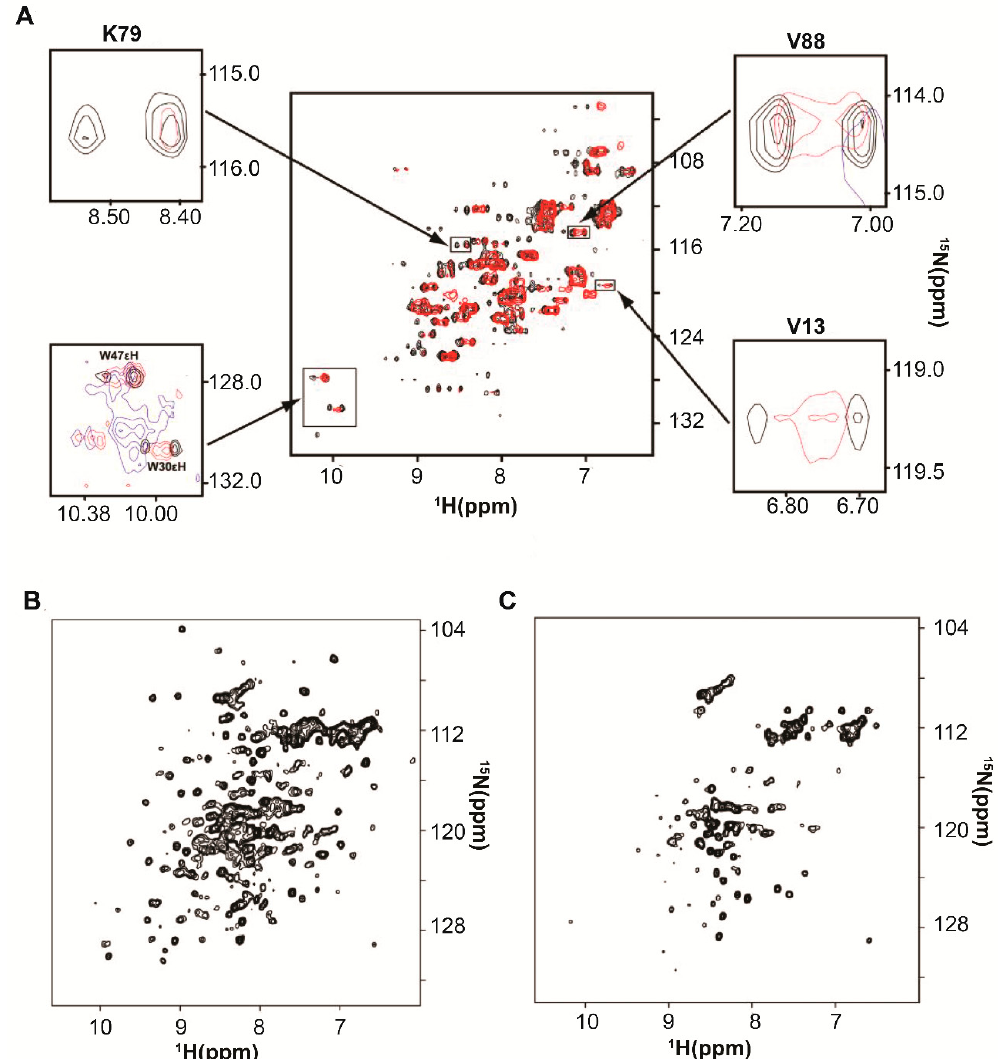
Figure 8. Dihydrofolate reductase, DHFR, and Thymidylate synthase, TS, engage in quinary interactions with RNA. ( A ) Overlay of in vitro 1 H- 15 N CRINEPT–HMQC–TROSY spectra of 200 µ M [ U - 2 H, 15 N] DHFR with 0.5 mM folate (black) and with 0.5 mM folate and 2.5 µ M ribosome (red). Insets show individual residue overlays that include in-cell NMR peaks (blue). Folate was added to increase the solubility of DHFR. ( B , C ) 1 H- 15 N HSQC spectra of 50 µ M [ U- 15 N] TS with ( B ) 0 µ g and ( C ) 135 µ g of total E. coli RNA. The figure is adapted from DeMott et al. (2017) [26].